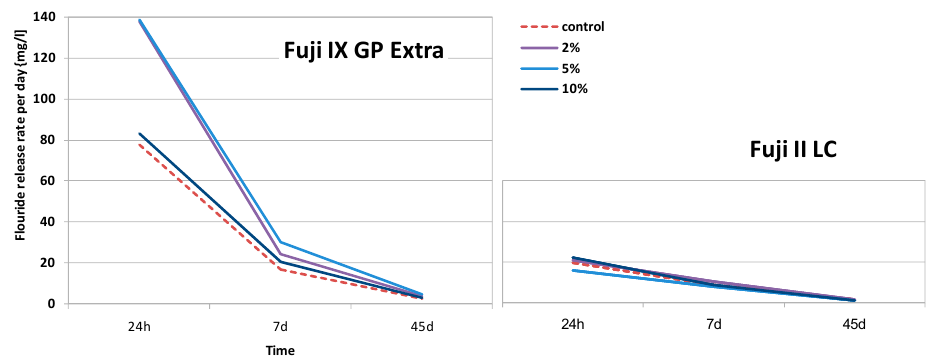
Figure 2. Fluoride release after 24 h, 7 days, and 45 days.